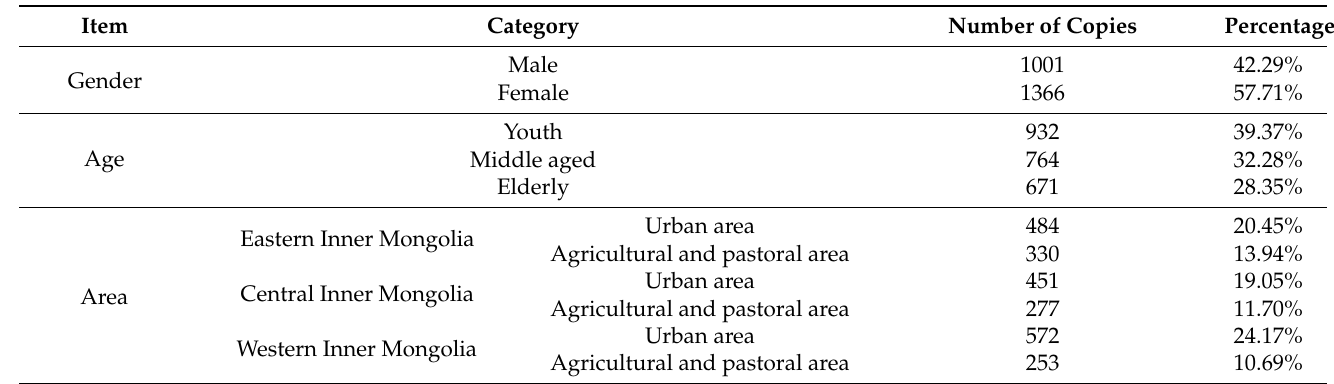
Table 2. Basic respondent